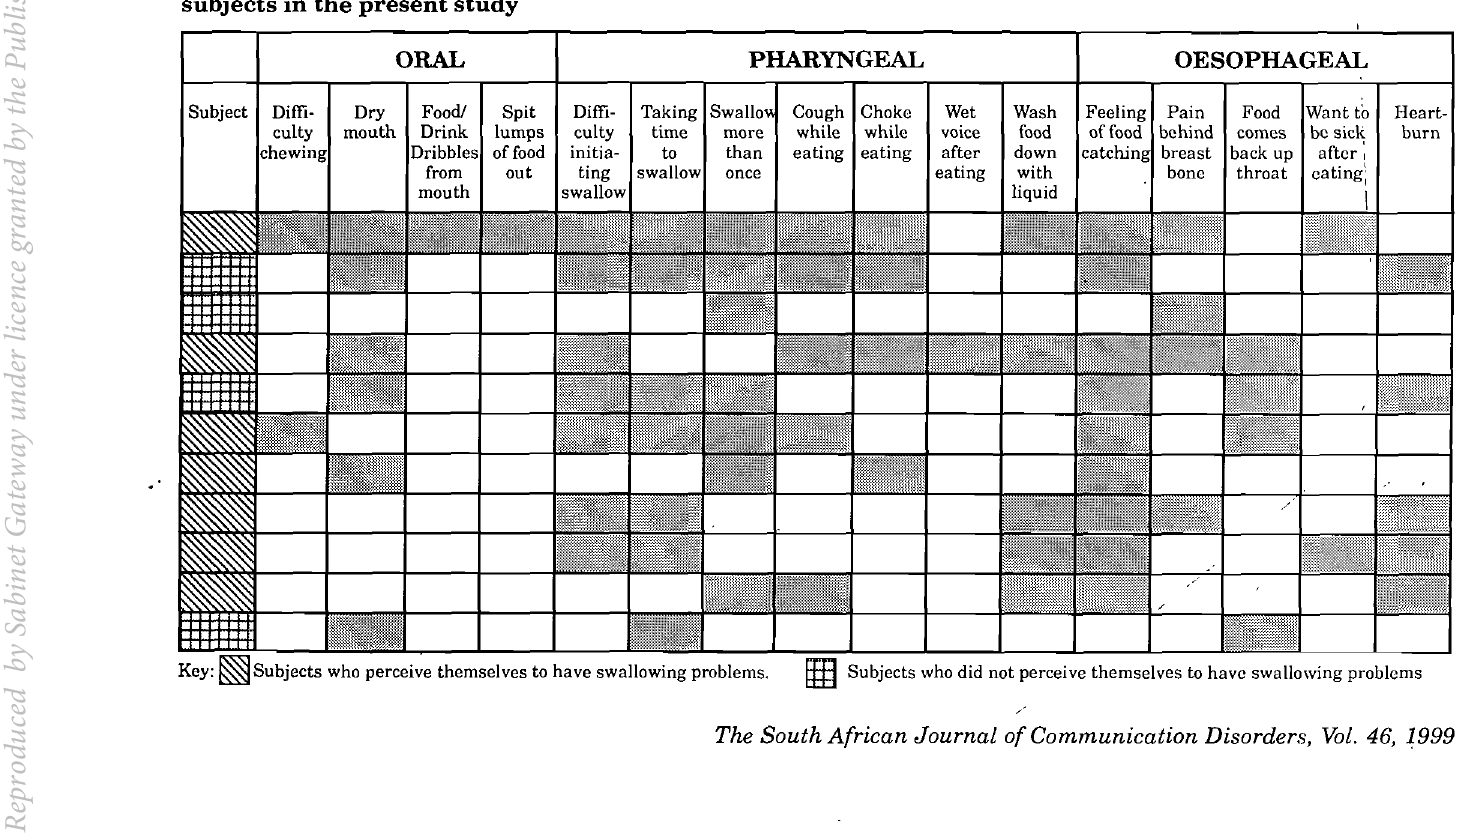
TABLE 3: Summary profile of the nature of swallowing difficulties reported to be experienced by the elderly subjects in the present